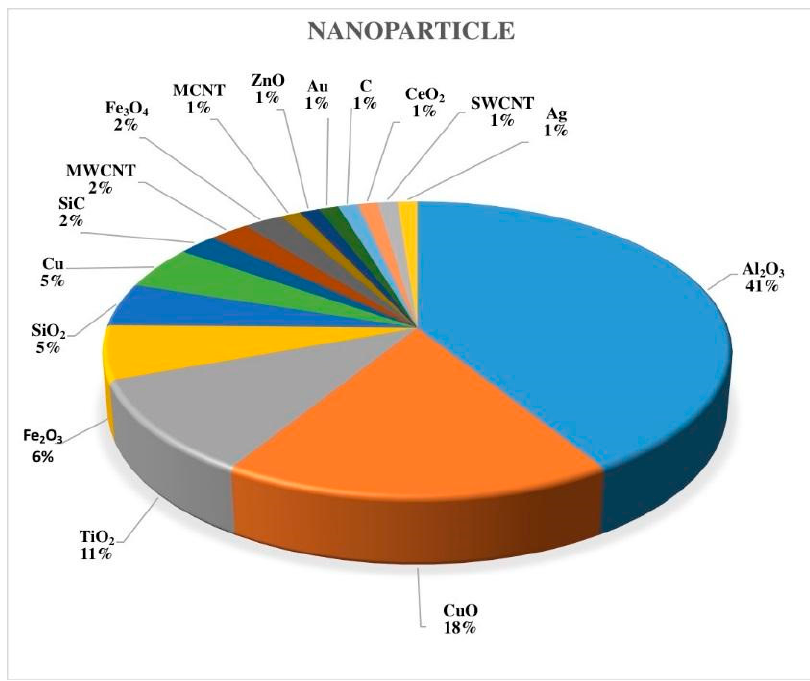
Figure 4. Share of different nanoparticles on the studies concerning PTC enhancement using nanofluids.